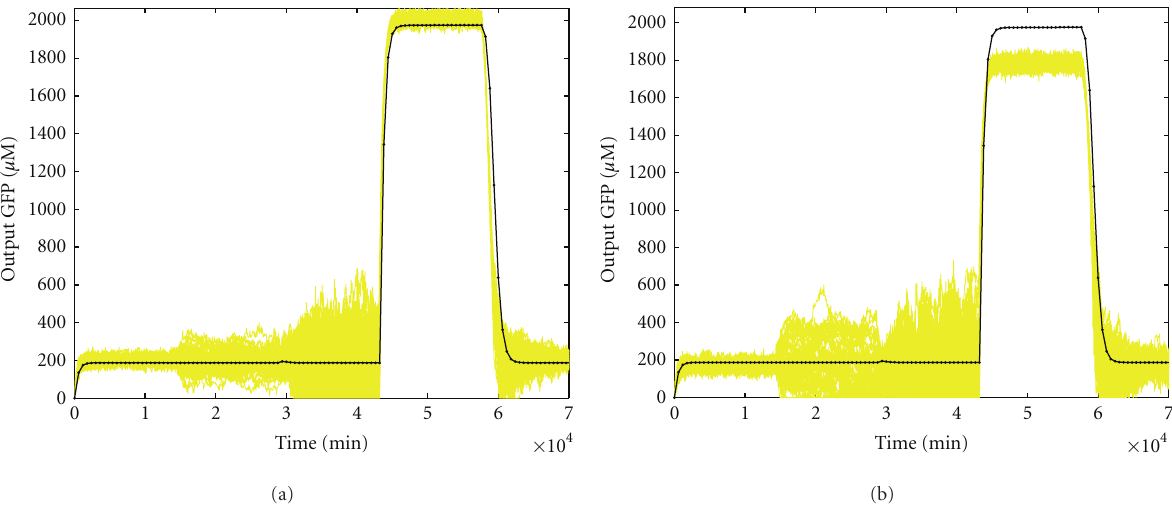
Figure 6: Simulation result of biological AND gate. (a) In order to confirm the robustness and filtering ability of the synthetic gene network, the parameters are specified as follows. The standard deviations of uncertain kinetic parameters and decay rates to be robustly tolerated are specified as Δ k 1 = 0 . 2, Δ k 2 = 0 . 2, Δ k 3 = 0 . 02, Δ k 4 = 0 . 02, Δ k 5 = 0 . 000005, Δ k 6 = 0 . 2, Δ k 7 = 0 . 02, Δ λ 1 = 0 . 04, Δ λ 2 = 0 . 04, Δ λ 3 = 0 . 05, Δ λ = 0 . 05, Δ λ = 0 . 05, Δ λ = 0 . 04, and Δ λ = 0 . 05. The variance of external disturbance v = (0 . 1) 2 . The Monte Carlo simulations are 2 (cid:8) 4 5 6 7 i is σ i 50 performed by 50 rounds. The mean error is e = (1 / 50) e i = 121 . 95 with a standard deviation of 9.93, where e i is the root mean squared i = 1 error of the i th Monte Carlo simulation. (b) In contrast to the above design case, the design parameters are specified aside the optimal design parameter k ∗ , with k 1 = 0 . 9, k 2 = 0 . 6, k 3 = 0 . 95, k 4 = 0 . 25, k 5 = 0 . 00002, k 6 = 0 . 6, and k 7 = 0 . 15. In this design case, the mean error is e = 165 . 90 with standard deviation of